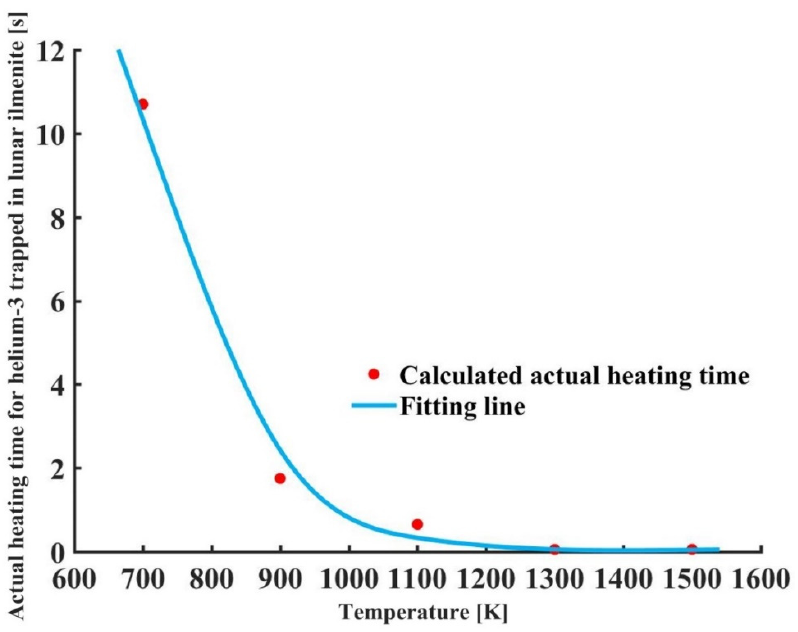
Figure 8. Variations in actual heating time for helium-3 trapped in lunar ilmenite with tempera- ture.